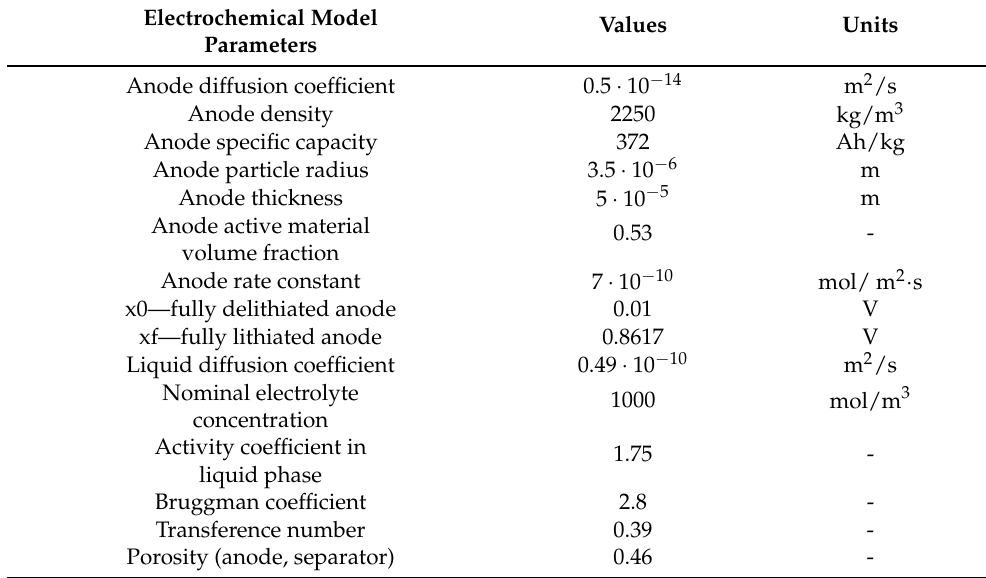
Table A1. Electrochemical model-tuned anode parameters in solid and liquid